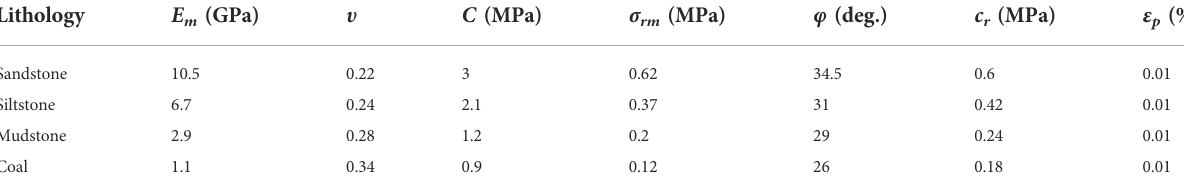
TABLE 3 Coal and rock mass properties in numerical